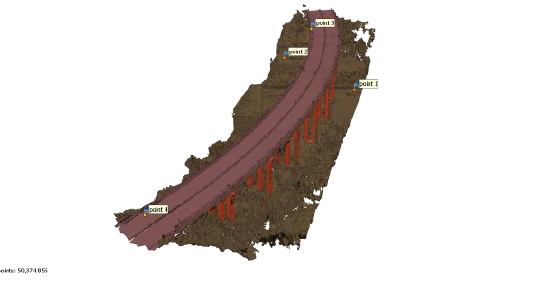
Figure 9. Annunziata Viaduct from UAV Photo (a), and 2d masks of the bridge (b) and deck (c) Using Supervise.ly online application the different masks to segment viaduct and deck were applied. The obtained alpha masks, with the use of Mask RCNN process, were transferred from 2d to 3d using “select by point” techniques. After the segmentation the class on the selected point were manually Figure 11. Fragility curve with PGA and exceeding assigned, according to the different parts.